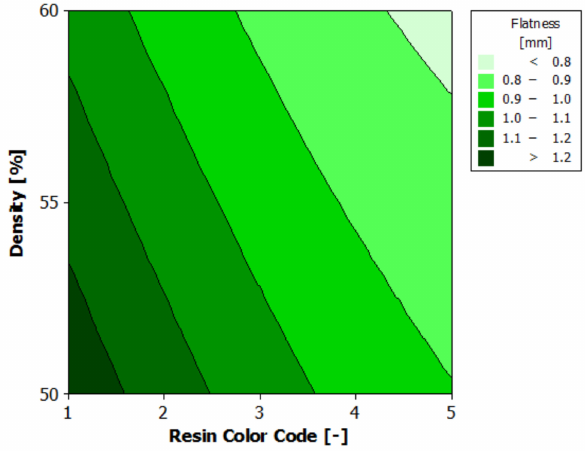
Figure 14. Contours of estimated response surface for flatness.